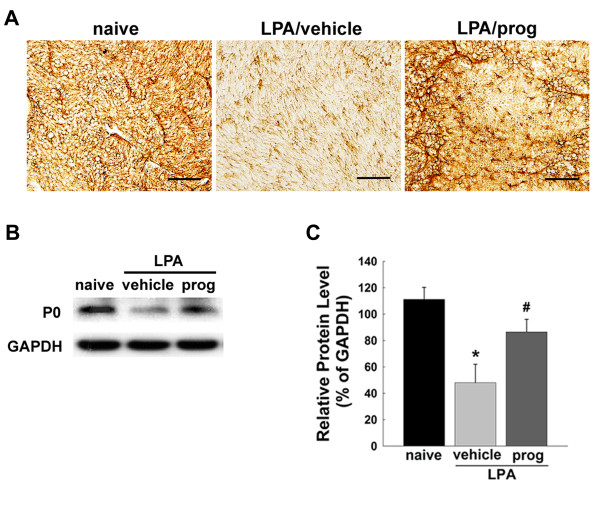
Effects of progesterone treatment (16 mg/kg/day) upon P0 expression. (A) Vehicle treatment did not affect the LPA-induced decreases in P0 expression in the trigeminal nerve root compared with naïve rats on postoperative day 5. However, decreased P0 expression, produced by LPA injection, was recovered following treatment with progesterone. (B) Western blot analysis confirmed that LPA injections cause a decrease in the 27 kDa band for P0, which was recovered by treatment with progesterone. GAPDH was used as a loading control. (C) Quantitative analyses of western blotting data. * P < 0.05, naive- vs. LPA/vehicle-treated group. # P < 0.05, LPA/vehicle-treated group vs. LPA/progesterone-treated group. Scale bar, 50 μm.